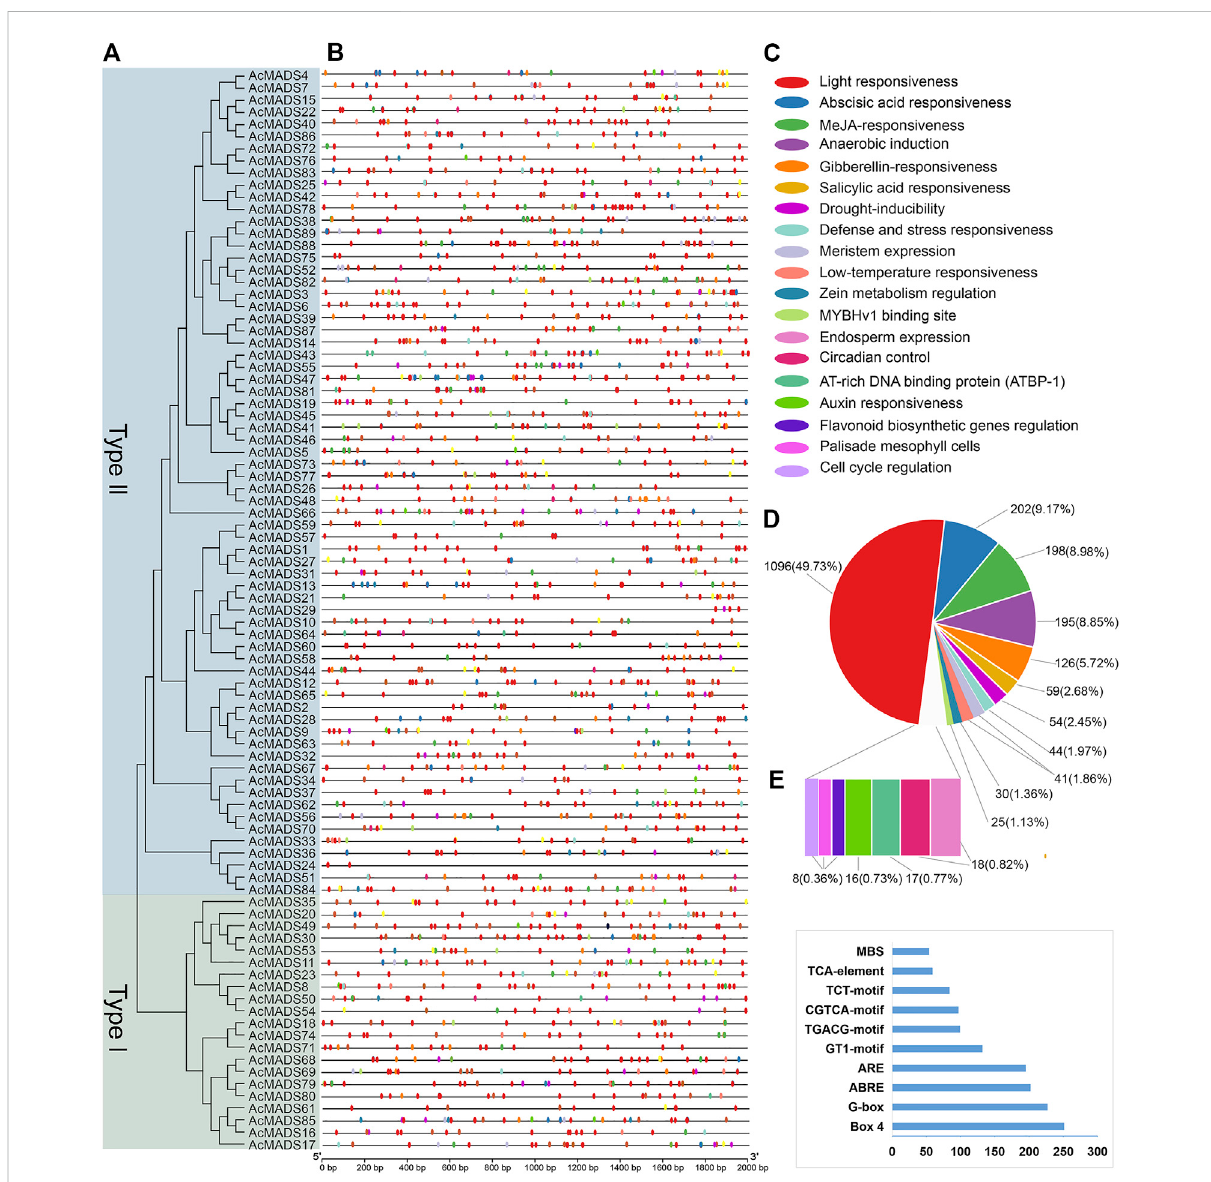
FIGURE 5 Cis -actingelementsofAcMADS-boxgenepromoterfrom A.chinensis . (A) Thephylogenetictreeof89AcMADS-boxproteins. (B) Thelocations of cis -acting elements in the promoter of 89 AcMADS-box genes. (C) The 19 types of functional modules are shown as fl at round boxes of different colors. (D) Statistical analysis of the 19 types of functional modules in cis -acting elements. (E) Statistics of the top 10 CAEs in 89 AcMADS-box gene promoters. Detailed information for each CAE is listed in Supplementary Table